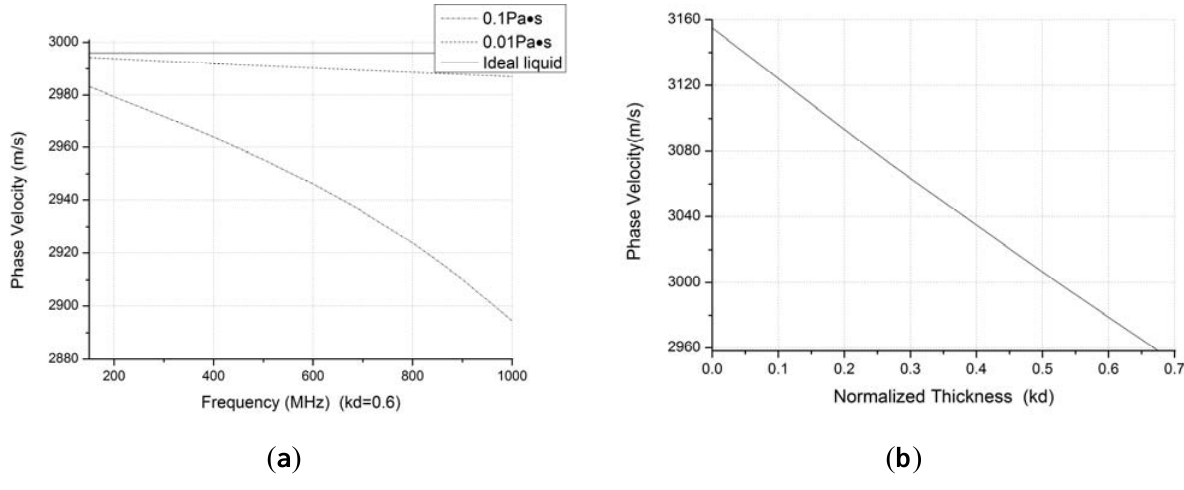
Figure 4. ( a ) Velocity shift from frequency effect and viscosity ( b ) Velocity shift from normalized thickness of